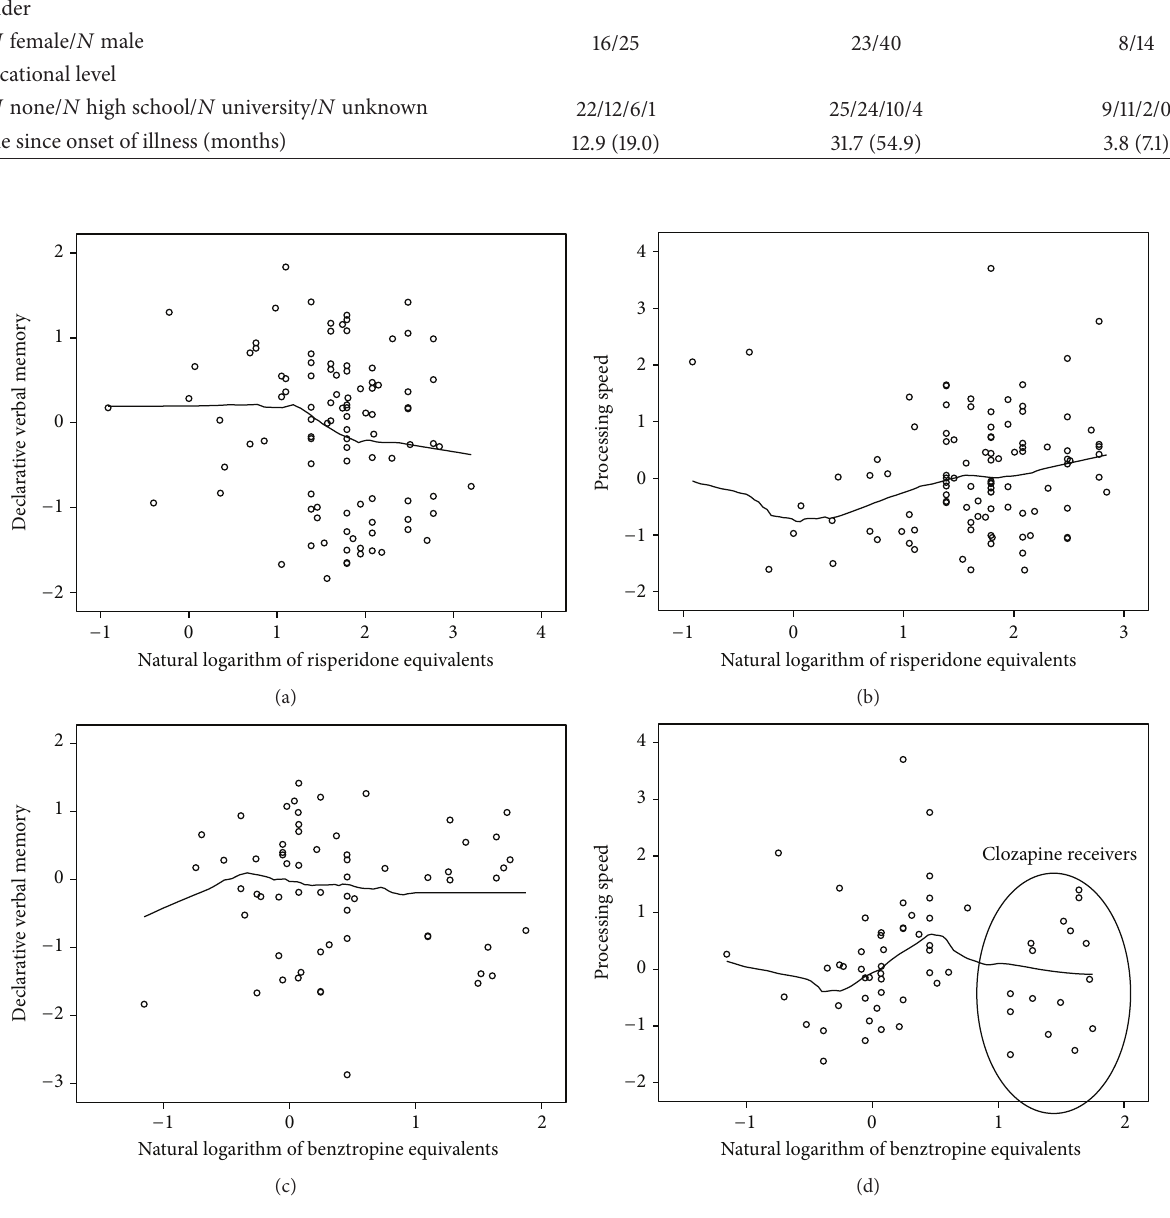
Figure 1: Locally weighted scatterplot smoothing (Loess) plot of cognitive performance in declarative memory and processing speed under escalating antipsychotic and anticholinergic daily